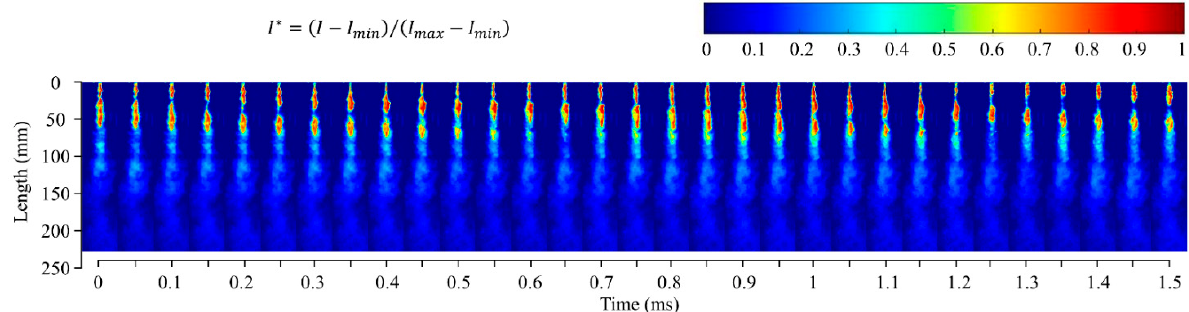
Figure 7. Space–time distribution of dimensionless grayscale intensity of cavitation cloud at a working pressure of 10 MPa.